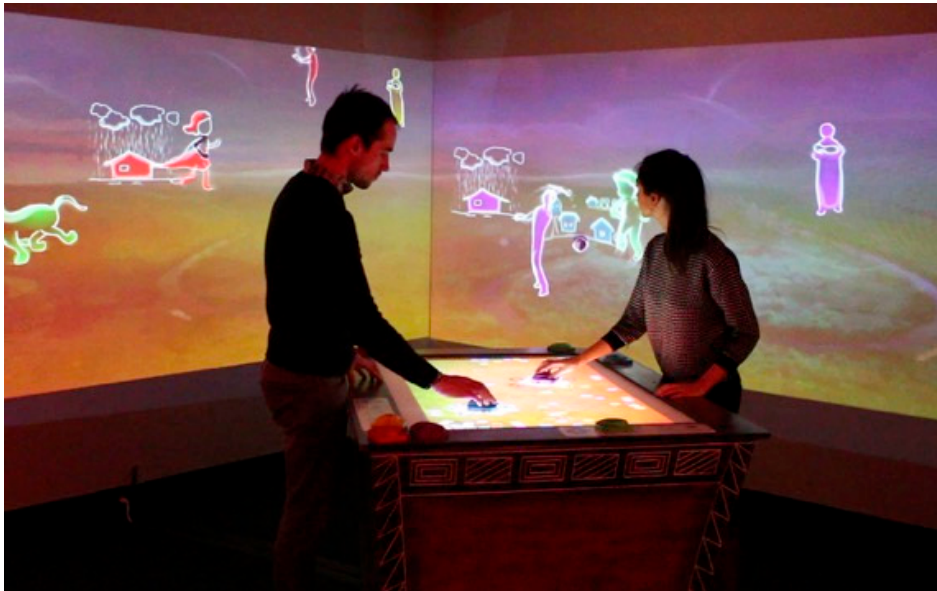
Figure 5. Lukasa-inspired tangible tabletop installation in the Mapping Place museum Figure 5. Lukasa ‐ inspired tangible tabletop installation in the Mapping Place museum exhibition.